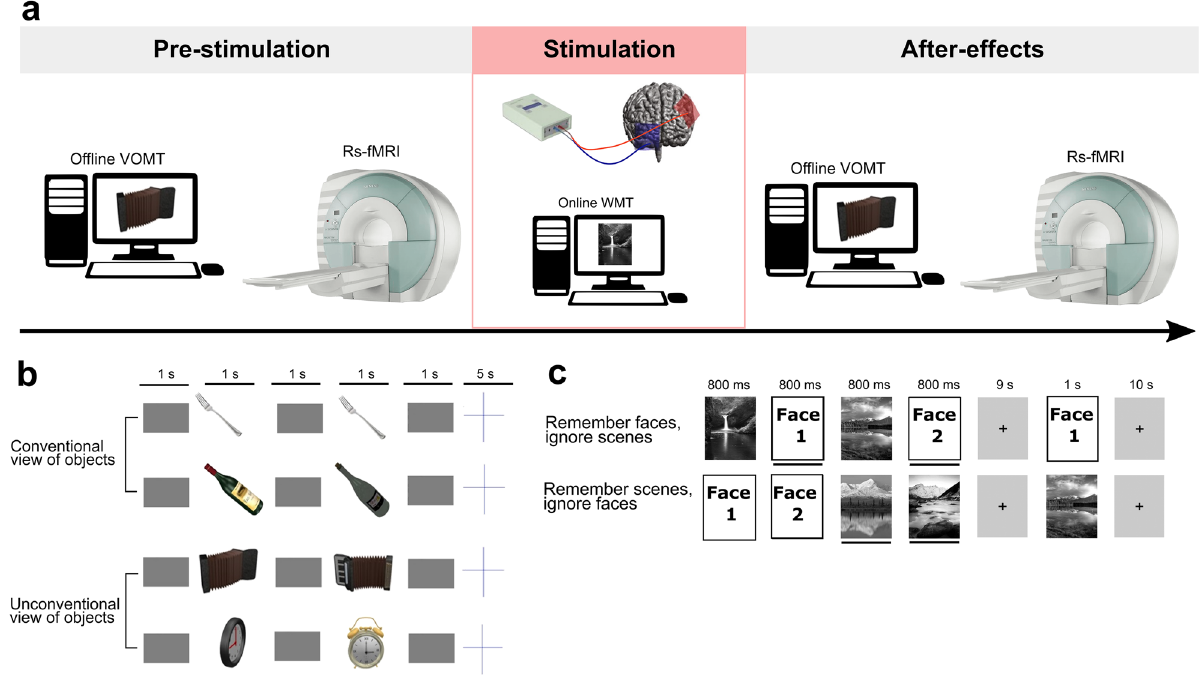
Figure 1. Experimental design and methods. ( a ) The crossover design involved two sessions with real 2 mA stimulation/ sham tDCS with a concurrent working memory task. Prior to and after the stimulation, participants performed a visual object matching task (VOMT) and underwent resting-state fMRI. ( b ) Offline VOMT—subjects respond whether the two consecutive objects are the same or different by pressing a YES/ NO button in two difficulty levels (conventional view of objects—lower difficulty level; unconventional view of objects—higher difficulty level). ( c ) Online WMT—subjects view a block of faces and scenes (2 + 2, randomized order) preceded by a specific command on how to react to a probe that follows each block. Subjects respond whether the probe is consistent/ inconsistent with the prior instruction by pressing a YES/NO button. Freely available face photographs from Chicago 87 and Glasgow 88 face databases were used as a face stimuli in the